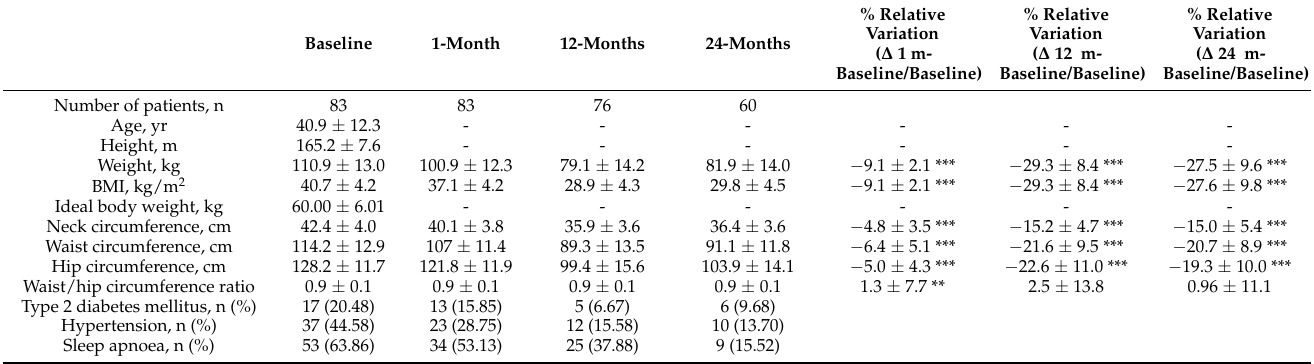
Table 1. Clinical characteristics of the patients at baseline and 1, 12 and 24 months after sleeve gastrectomy.